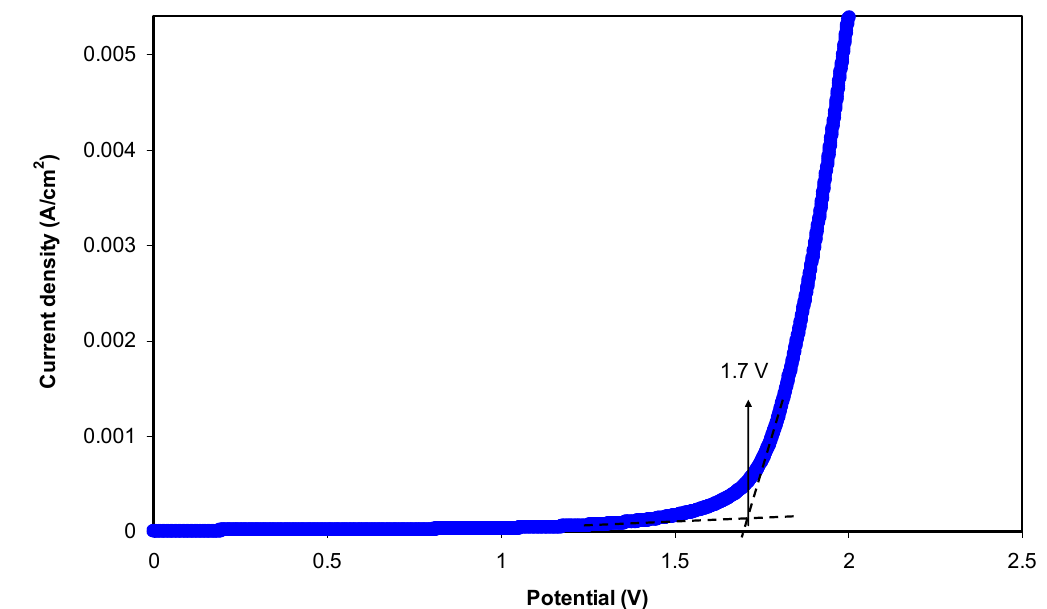
Figure 7. Linear sweep voltammetry (LSV) plot for the highest conducting (CSDX4) blend electrolyte film.